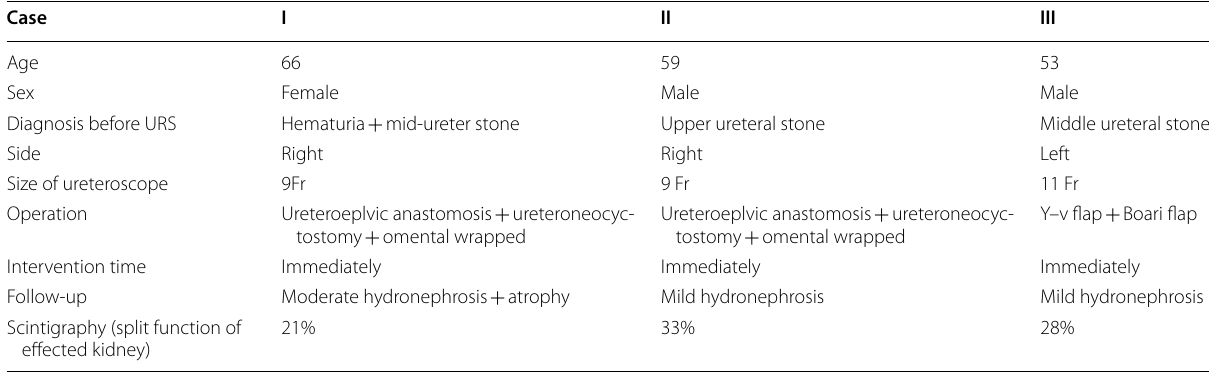
Table 1 Patients and operation